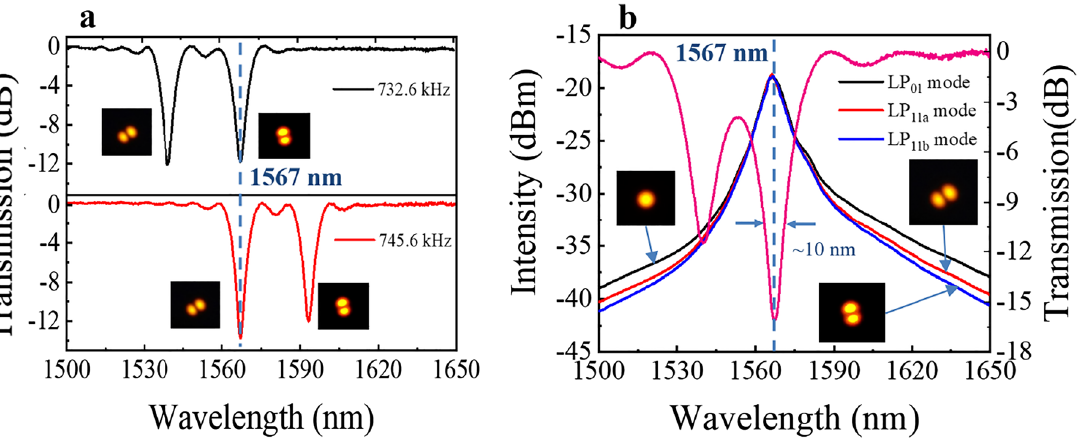
Figure 8: (a) The dual-resonant transmission spectra of the AIFG in the cavity. (b) Optical spectra of mode-locking states of LP 01 , LP 11a , and LP 11b modes.